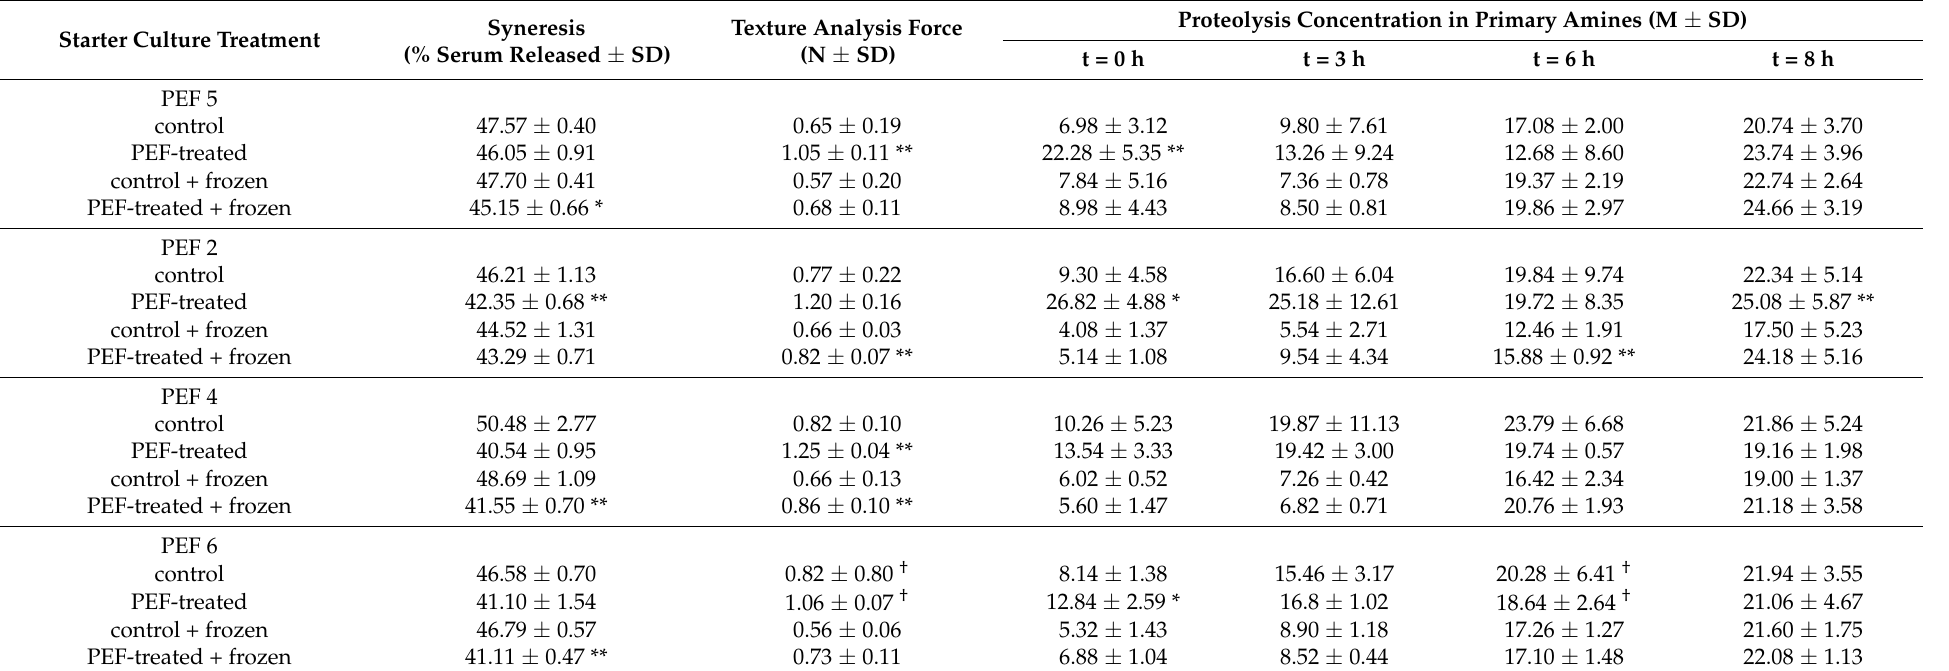
Table 4. Syneresis, yogurt stiffness, and development of proteolysis in yogurts made with-PEF treated and non-PEF-treated cells (control), with (frozen) and without a subsequent freeze–thaw cycle ( n =